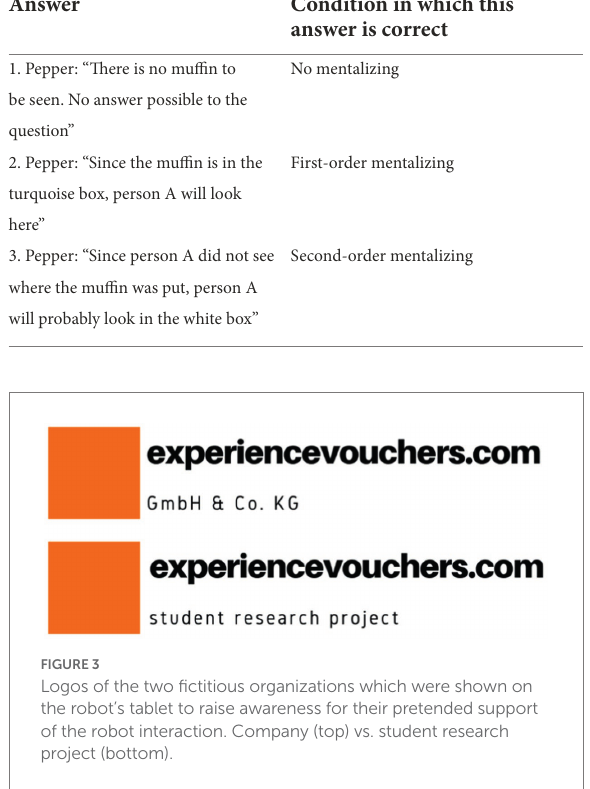
TABLE 2 Question, possible answers, and related conditions for the first picture story (Figure 2).